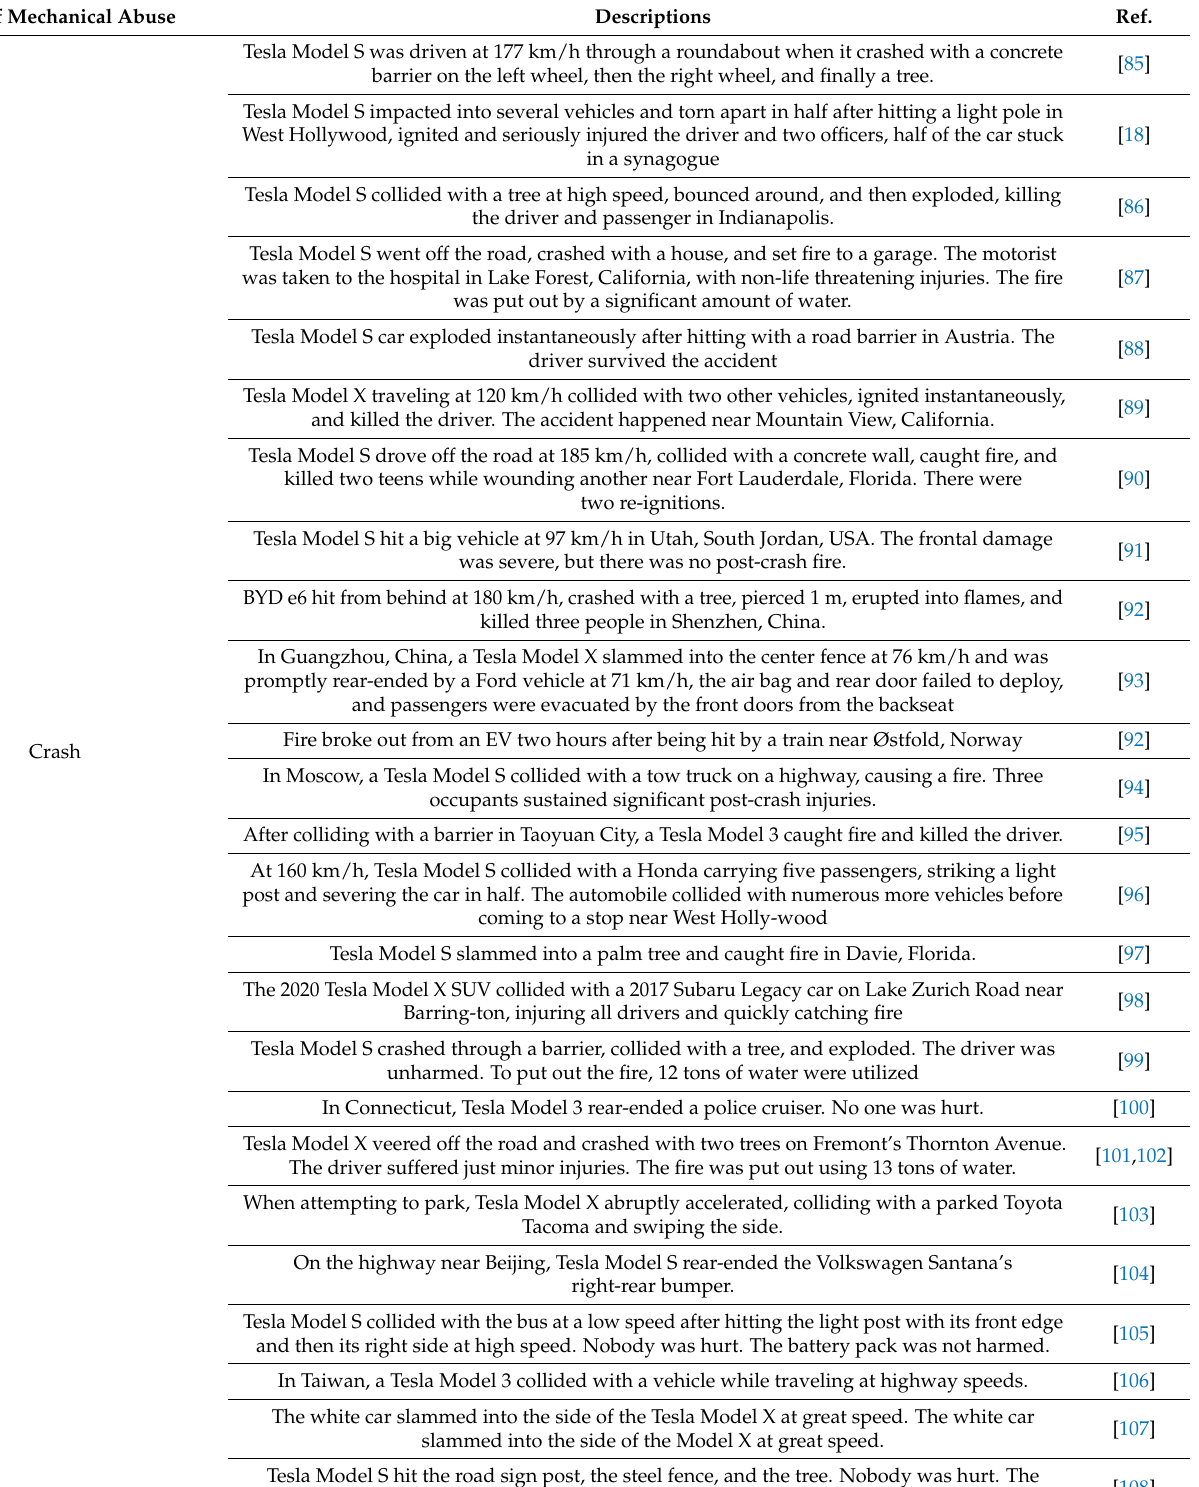
Table 3. Real-world EVs’ fire incidents in the form of mechanical abuses. Descriptions